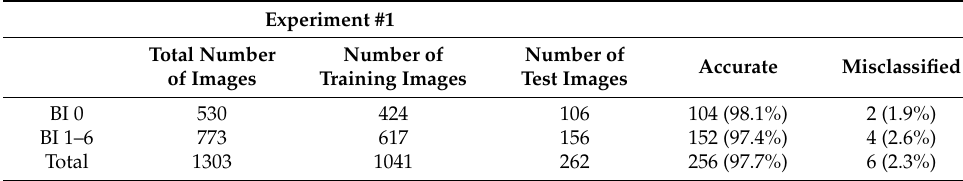
Figure 3. Examples of the expert-labeled training images used in our algorithm. Overall, 1303 core and outcrop images are labeled based on their bioturbation indices. Table 1. Results of experiment #1.